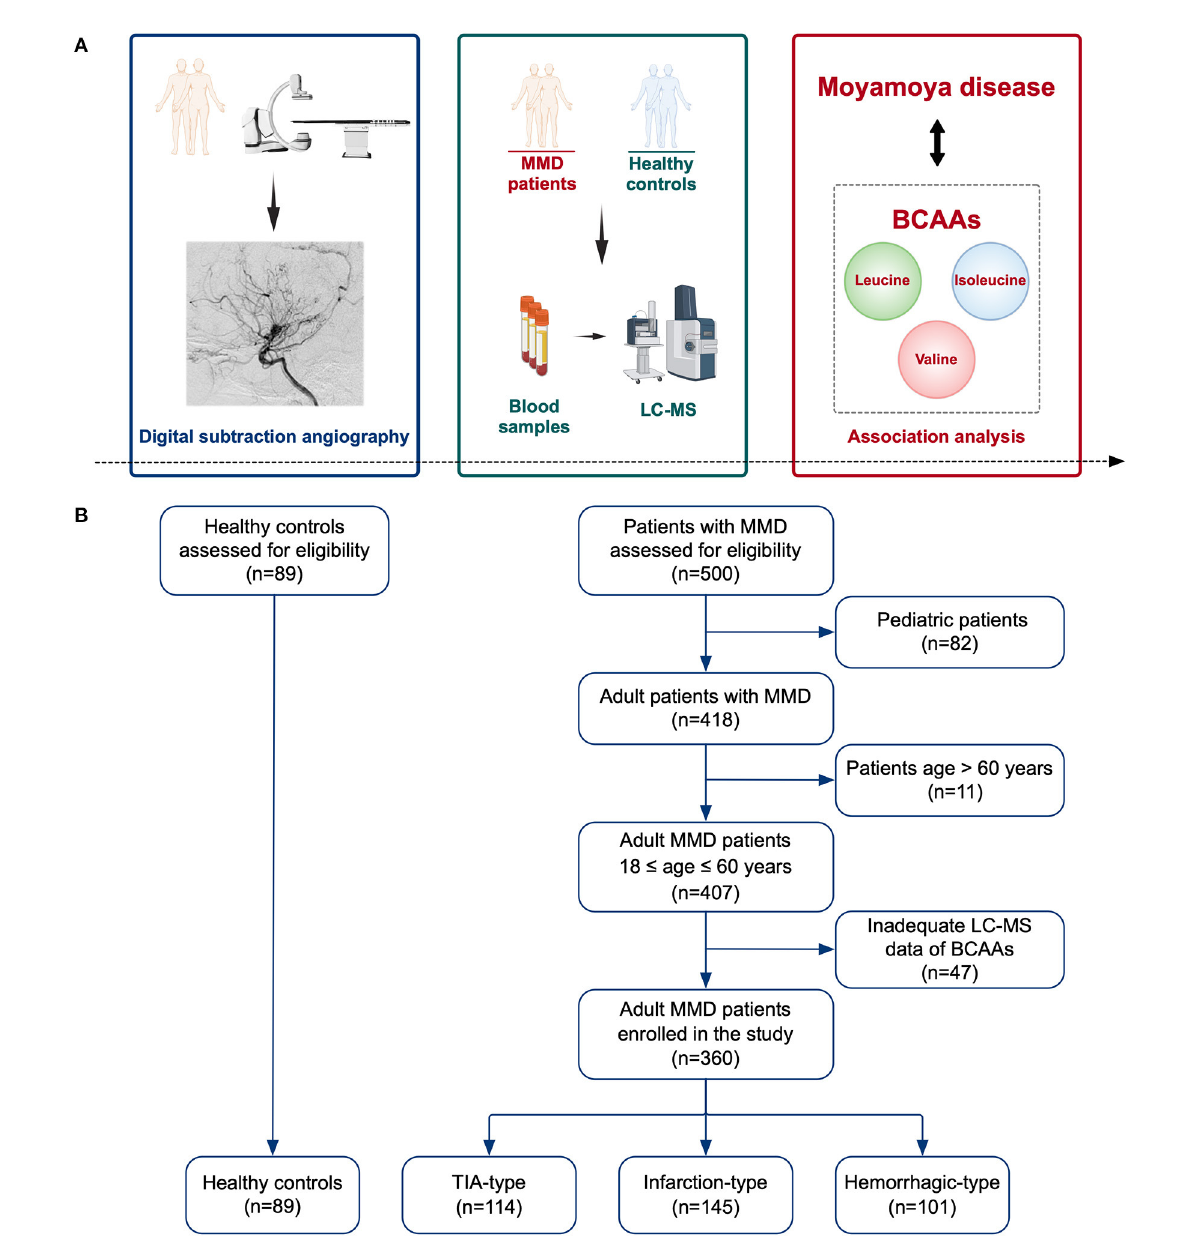
FIGURE1 Schematic diagram of the study. (A) Illustration of the study methods and purpose. (B) Flow chart of the study participants. MMD, moyamoya disease; LC-MS, liquid chromatography-mass spectrometry; BCAAs, branched-chain amino acids; TIA, transient ischemic attack.